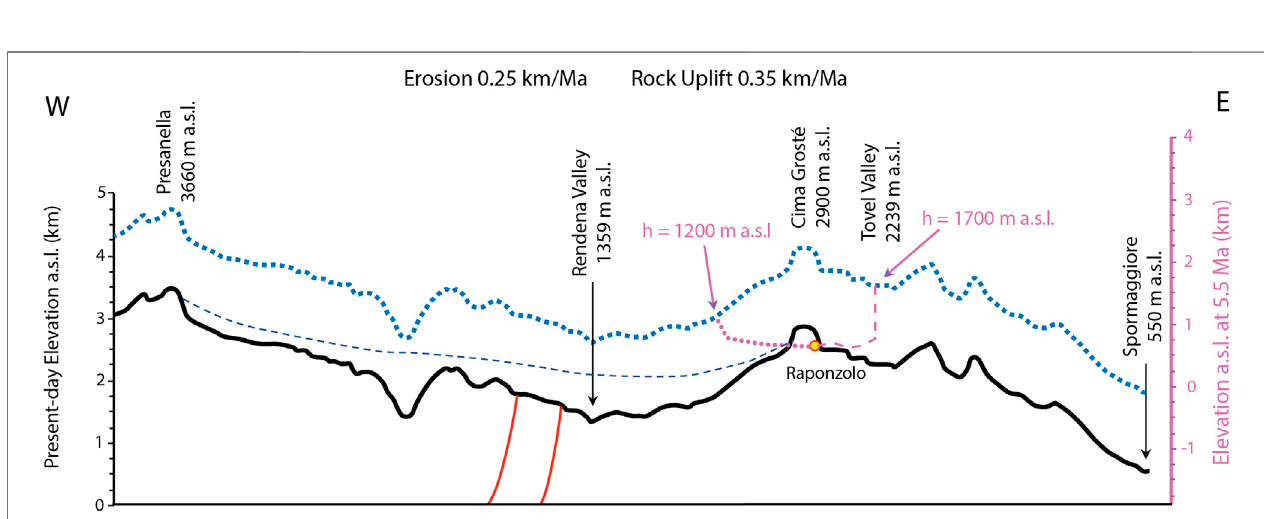
FIGURE12| West-eastpro fi leacrosstheAdamelloandBrentamassifswiththetheoreticalreconstructionofthereliefat5.5 Ma(dottedblueline).Forsimplicitythe relief projection is based on a theoretical constant and uniform erosion rate of 0.25 km/Ma and rock uplift rate of 0.35 km/Ma, even if erosion and uplift have been surely acting with slightly different rates depending on lithologies and tectonic domains. This reconstruction is based on the assumption that nowadays valleys and prominent reliefs should have been following the footprint of the Messinian major base level drop during the Mediterranean salinity, similarly to other regions of the Alps (Garzanti and Malusà, 2008). The theoretical vertical pro fi les of the Raponzolo cave are represented by bold purple line (catchment in the upper Tovel valley) and dotted purple line (catchment in the Rendena valley). The dashed blue line represents the ice extent in the Rendena Valley during the Last Glacial Maximum (Trevisan, 1939).